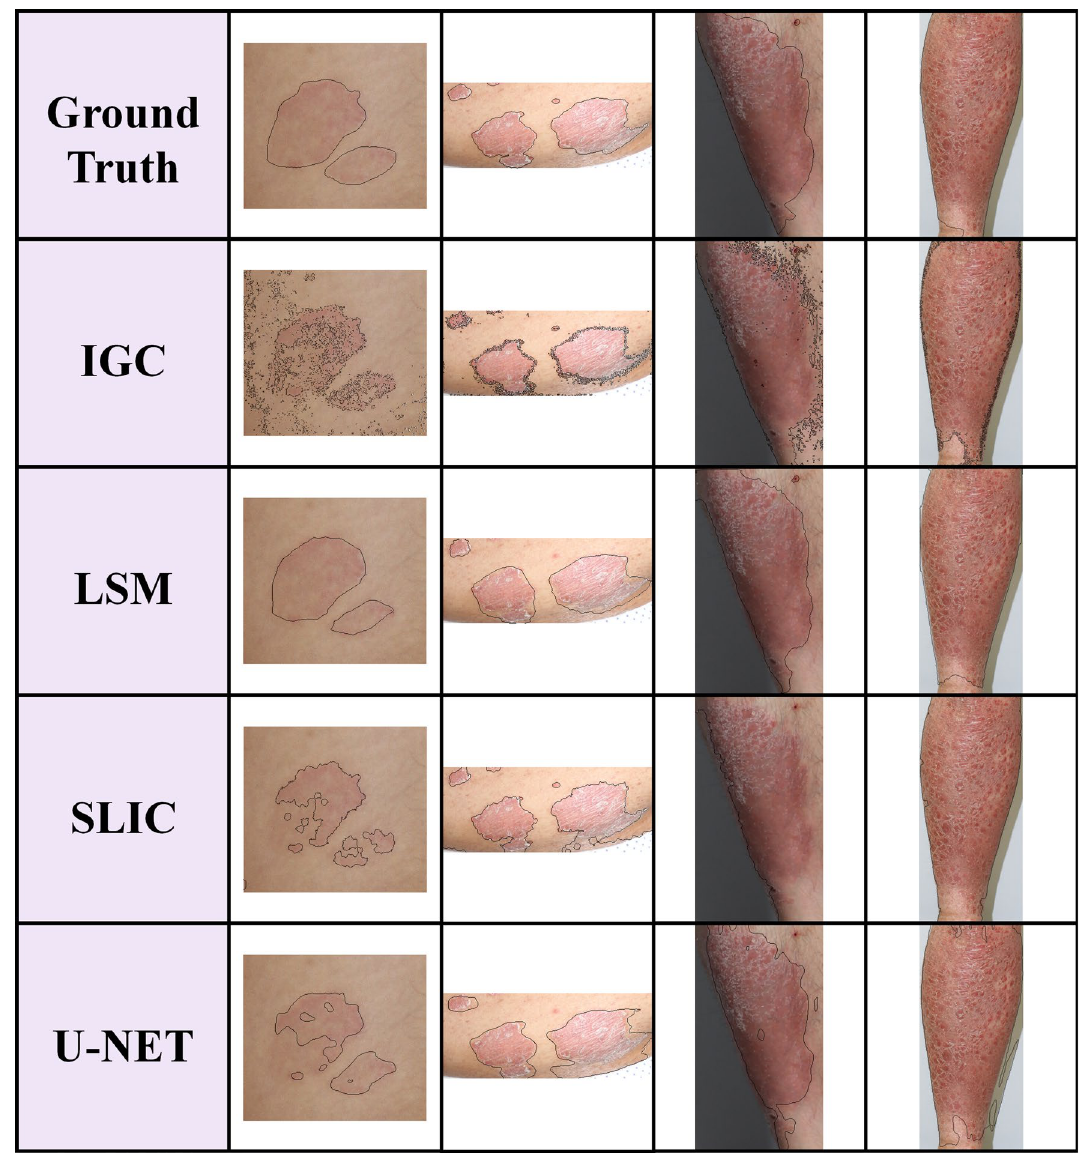
Figure 2. Psoriasis segmentation results of four segmentation methods, IGC, LSM, SLIC superpixels, and U-Net. The columns show psoriasis lesion images with different shapes, sizes, colors, and severities. It shows the segmentation results of IGC, LSM, SLIC superpixels, and U-Net, where the disease ambiguous or environmental noises such as shadows, lighting, etc., make accurate segmentation performance